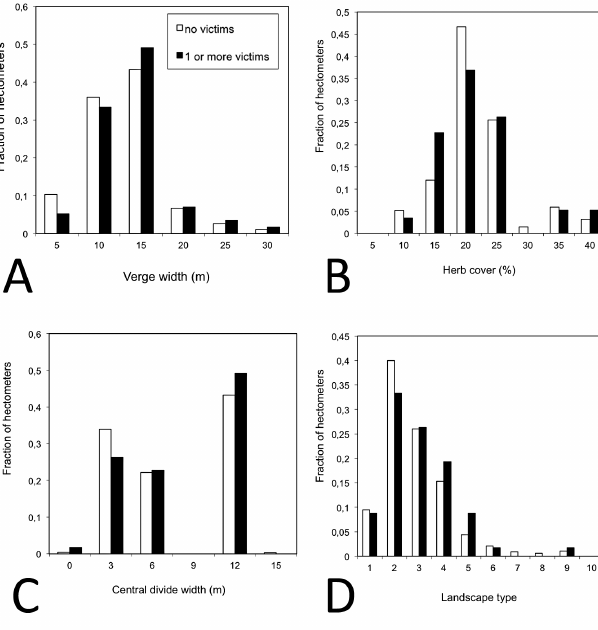
Fig. 12 . Distributions of road typology with and without owl victims. There are no statistical differences in terms of verge width (A), herb cover (B), central divide width (C), and landscape type (D; landscape types indicated in the text according to De Jong 2009; Chi squared yields for all comparisons p >